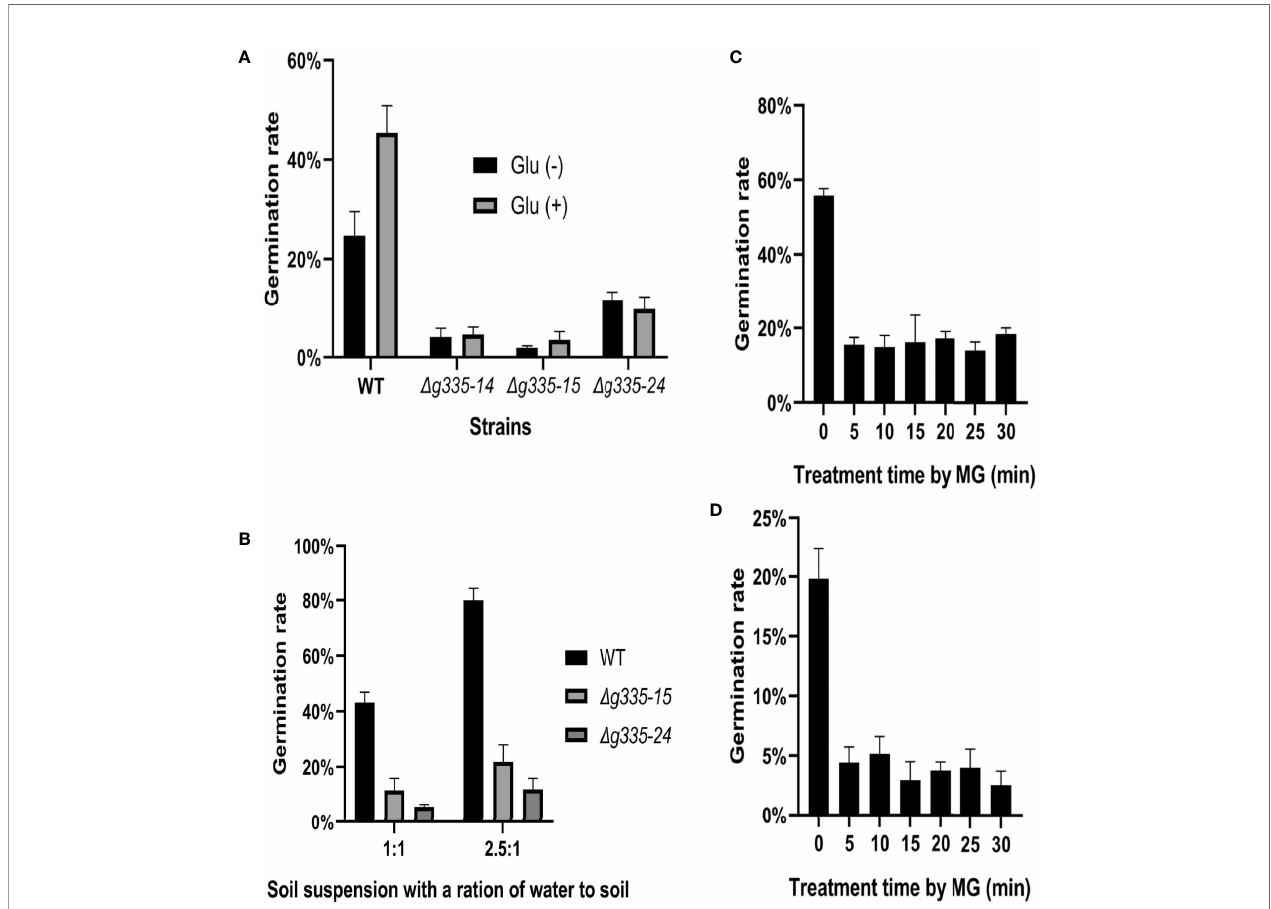
FIGURE 5 | The function determination of AOL_s00004g335 in resisting soil fungistasis. (A) The conidial germination rates (24 h) of mutant and wild type strains were determined in high fungistatic soil suspension (glu-), and the relief effect of conidial germination rates by glucose was compared in high fungistatic soil suspension (glu+). (B) Determine the conidial germination rates (24h) of mutant and wild type strains in medium fungistatic soil suspension (1:1), or low fungistatic soil suspension (2.5:1). (C, D) The conidia of wild type strain were treated by MG for different time, then placed in high fungistatic soil suspension (C) , or medium fungistatic soil suspension (D) for 24h, and determine the conidial germination rate. WT, wild-type strain. D g335-14 , D g335-15 , and D g335-24 : AOL_s00004g335 knock-out mutants. Glu(-), conidia suspension without glucose. Glu(+), conidia suspension with